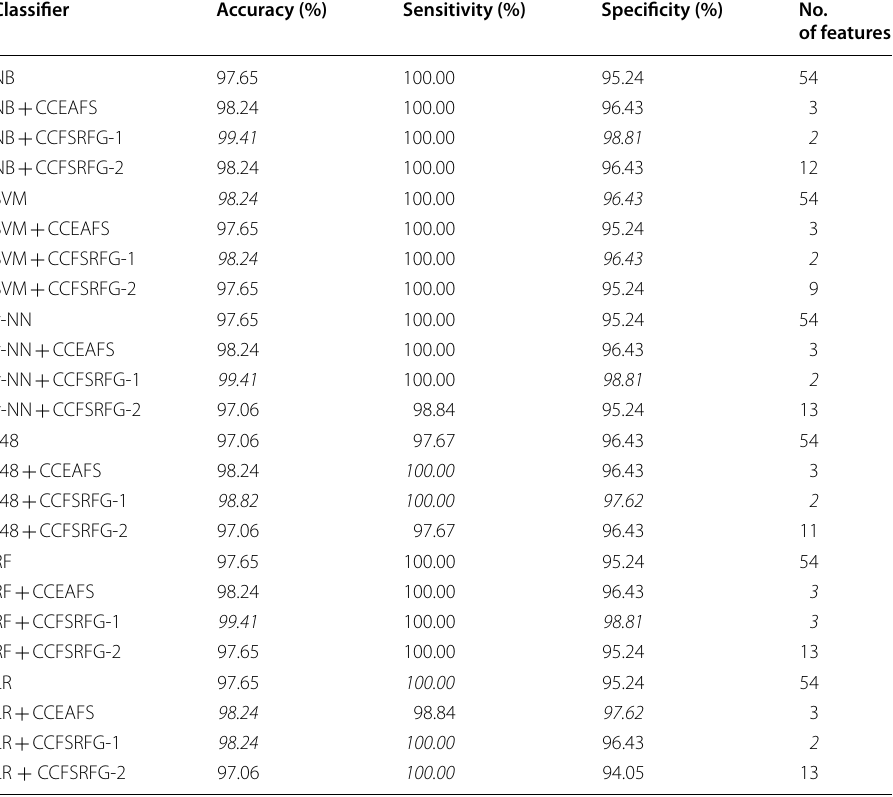
Italic signifies the improvements of the proposed approach over existing techniques